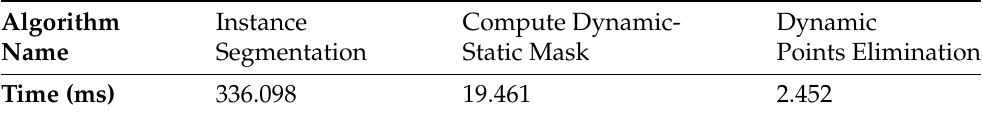
Table 9. Algorithm running time